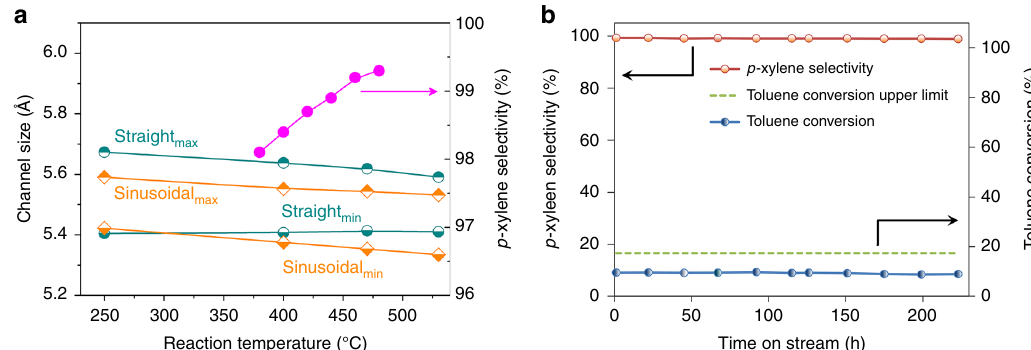
Fig. 1 Catalytic performances of HZSM-5_T catalyst in methanol – toluene alkylation reaction. a Effects of reaction temperature on ZSM-5 shape-selectivity to p -xylene, and on ZSM-5 straight channel and sinusoidal channel sizes, where subscript max and min refers to the longest and shortest diameter of the elliptical cross-section of ZSM-5 ′ s channel respectively, obtained from computed crystallographic data in Supplementary Fig. 3 and Supplementary Table 2. b Toluene conversion and p -xylene selectivity evolution with time on stream, where the upper limit of toluene conversion marked with dashed green line is 16.6% (470 °C; atmospheric pressure; toluene/methanol (mol/mol) = 6 was co-fed with hydrogen and water; see Methods for details)